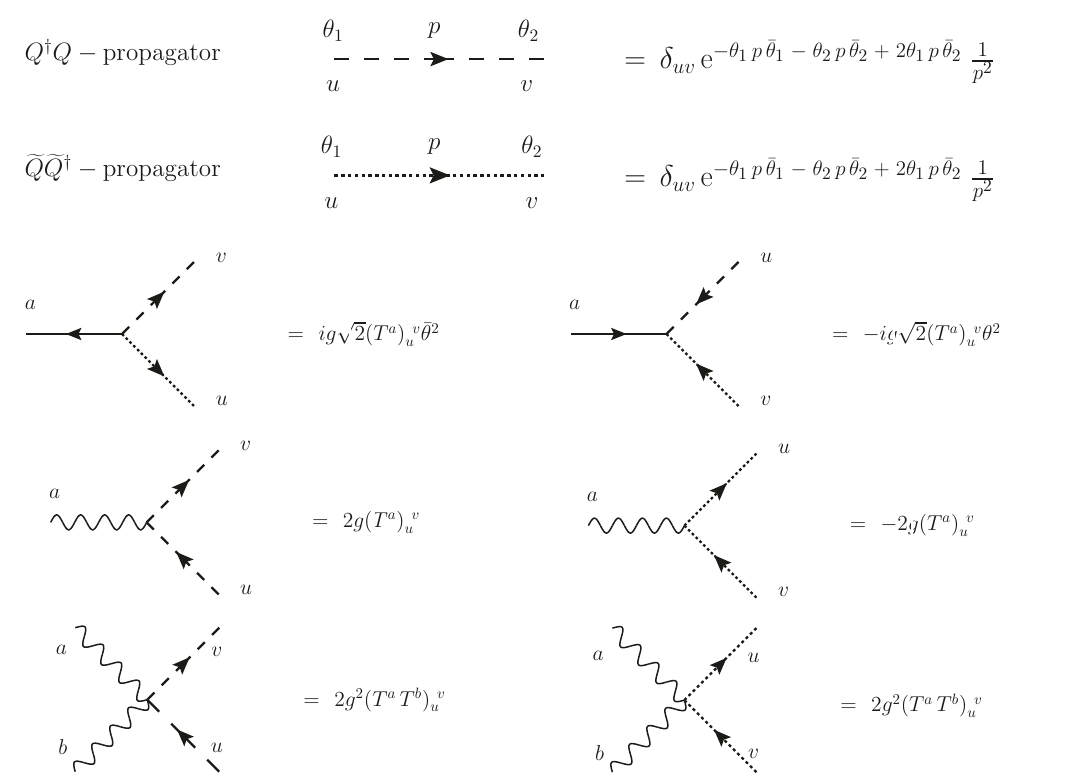
Figure 2 . Feynman rules involving the matter super(cid:12)elds that are relevant for our calculations. So it corresponds simply to the case in which = 1 super(cid:12)elds, beside V and (cid:8), it contains also two adjoint chiral multiplets that we N call H